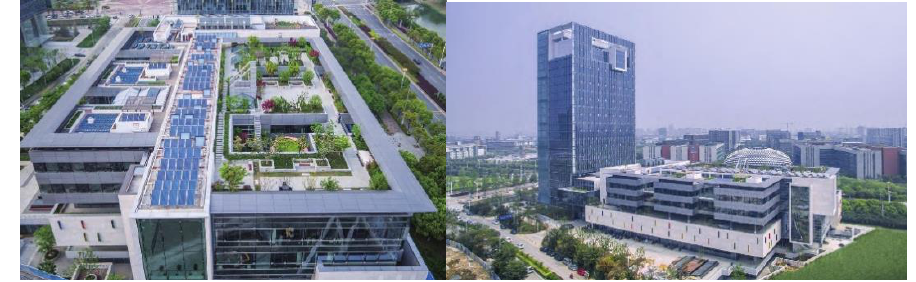
Figure 8. Zhongheng Design Center Building.